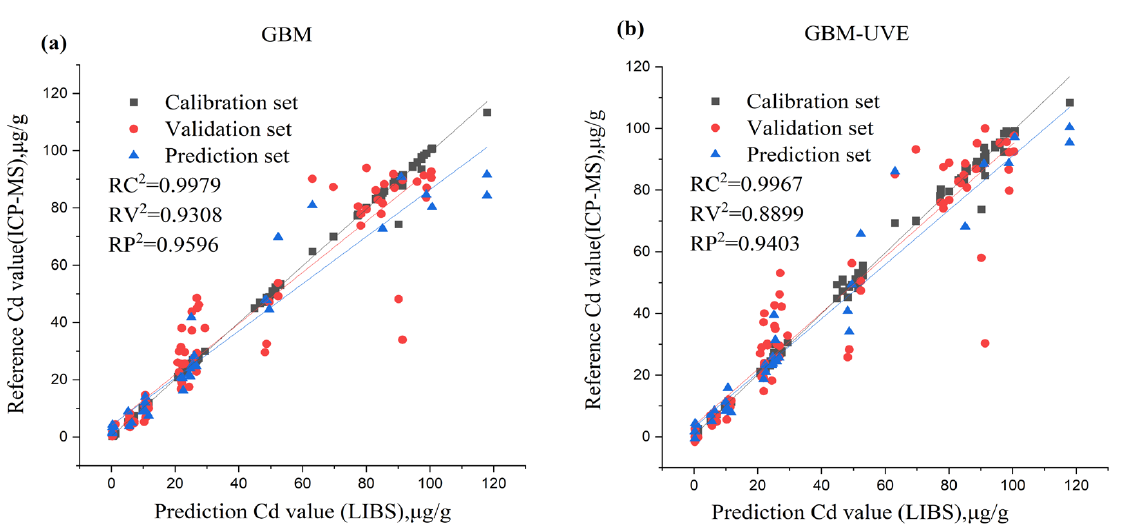
Figure 4. ( a ) Scatter plots of the full variables and reference value ( b ) Scatter plots of GBM combined with UVE feature selection method and reference value for the content of Cd.